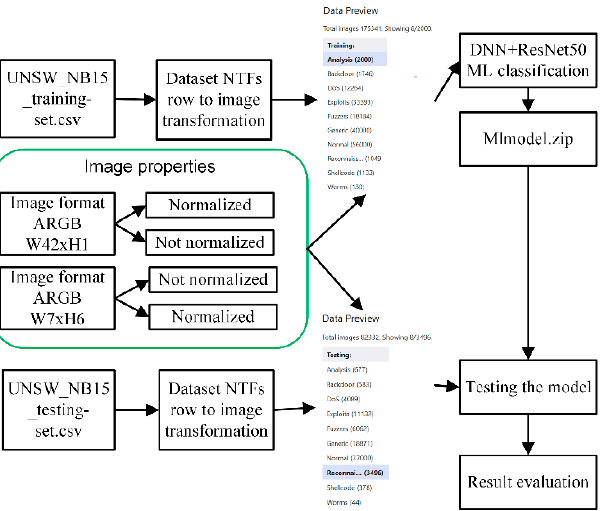
Figure 5. Proposed image transformation process for network intrusion detection using multistage deep learning image recognition.